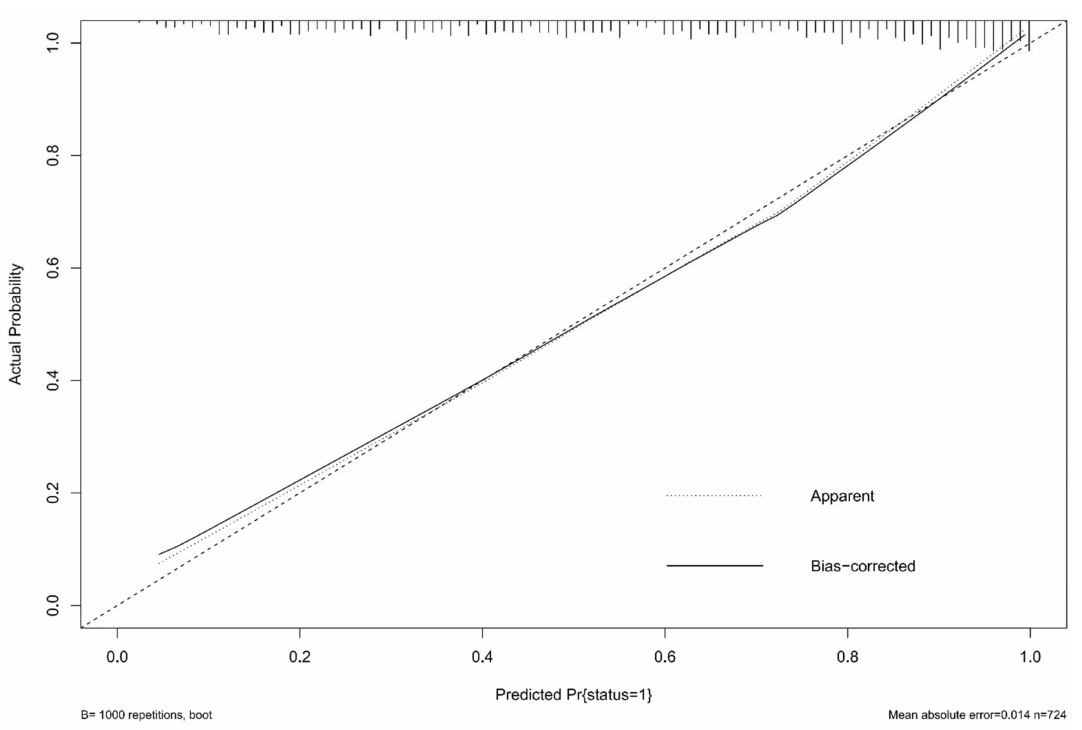
Figure 3. Calibration curve of the nomogram for predicting